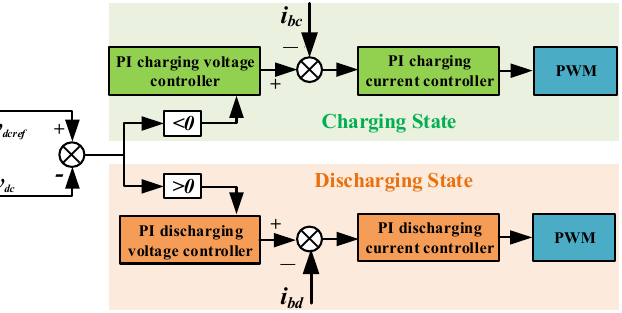
Figure 3. Control principles of energy storage Buck ‐ Boost converter.